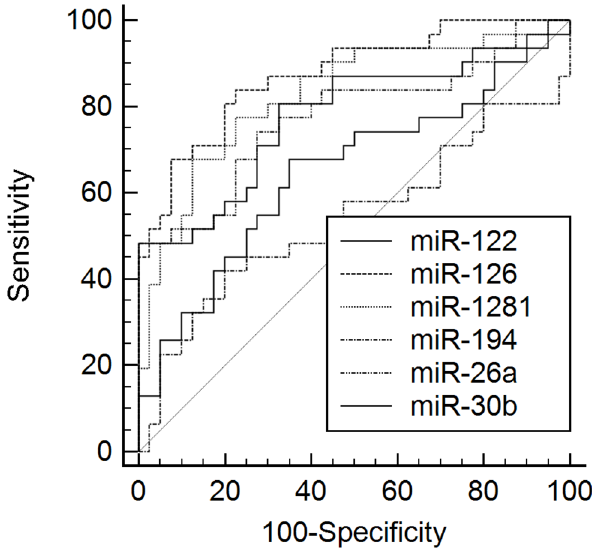
Fig 3. ROC curves for serum miRNAs. Receiver operating characteristics (ROC) curves for the detected serum MIRNAs. MiR-1281 and miR-126 showed the highest area under the curve (AUC) value in ROC curve analysis.